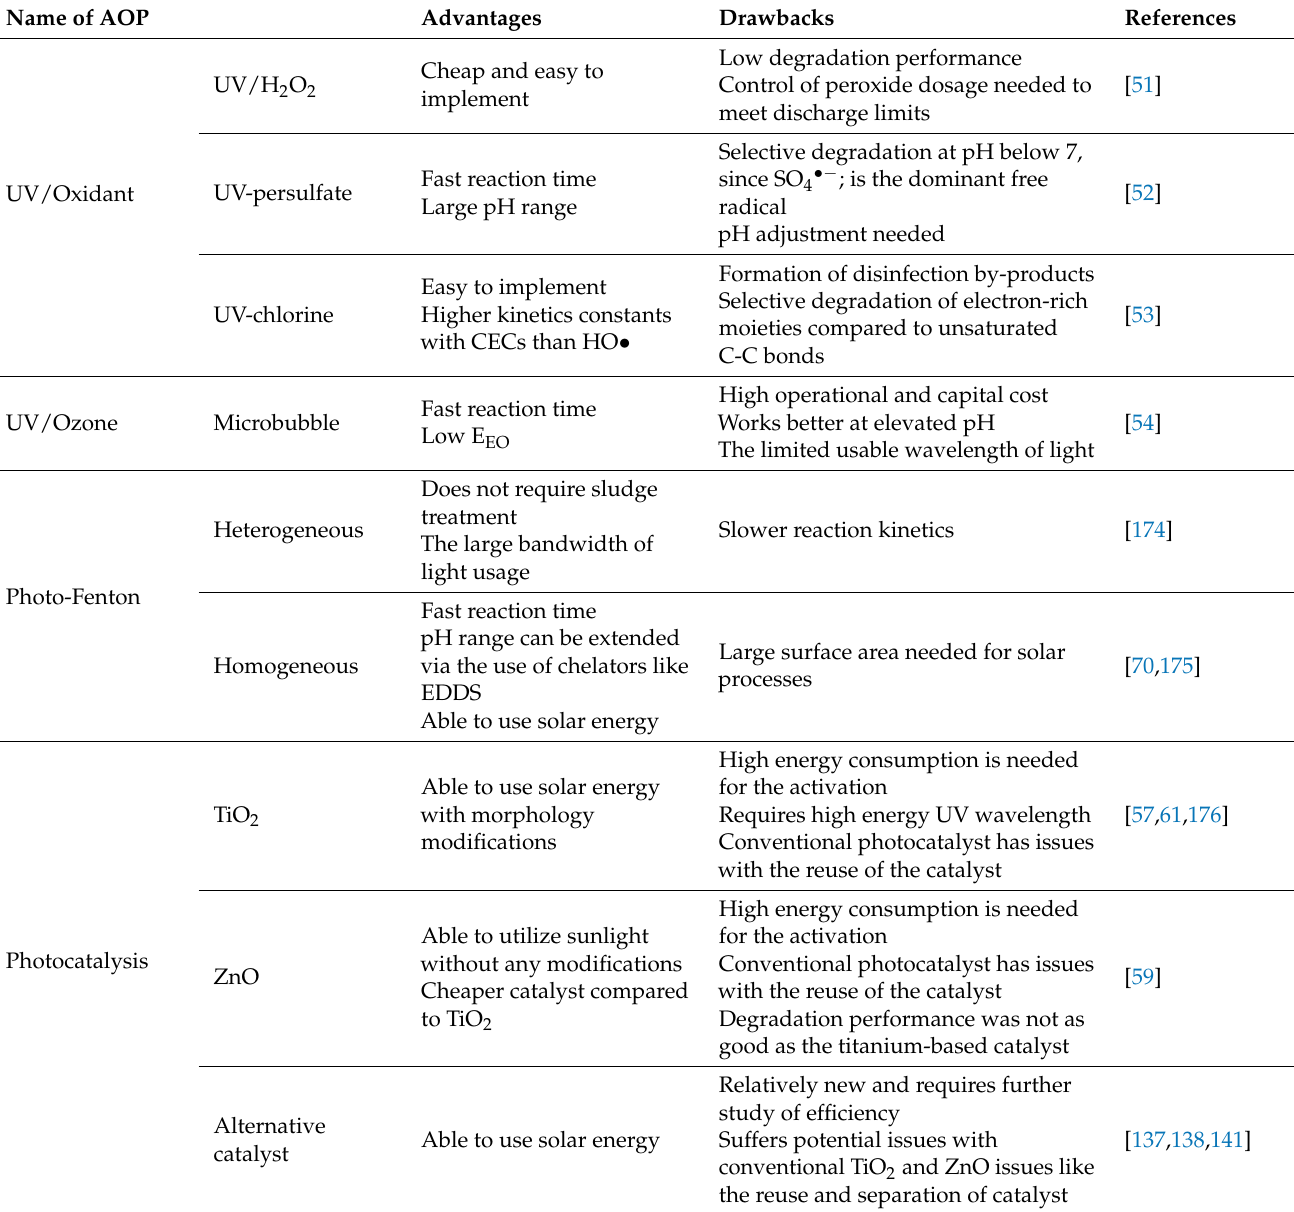
Table 9. Advantages and disadvantages of light-driven